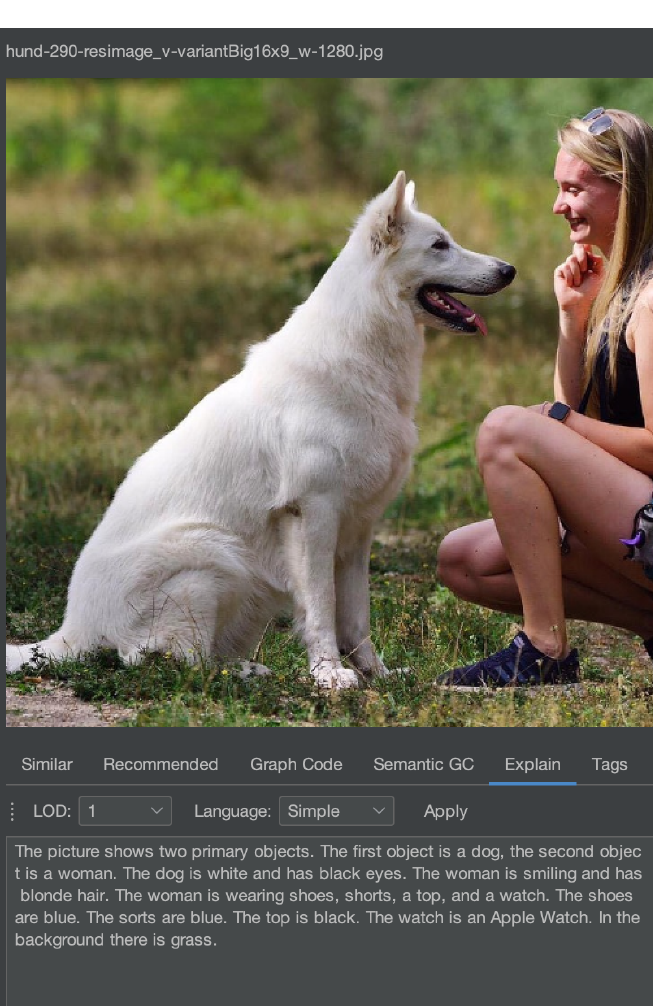
Figure 13. GMAF-UI displaying a human-readable explanation of an